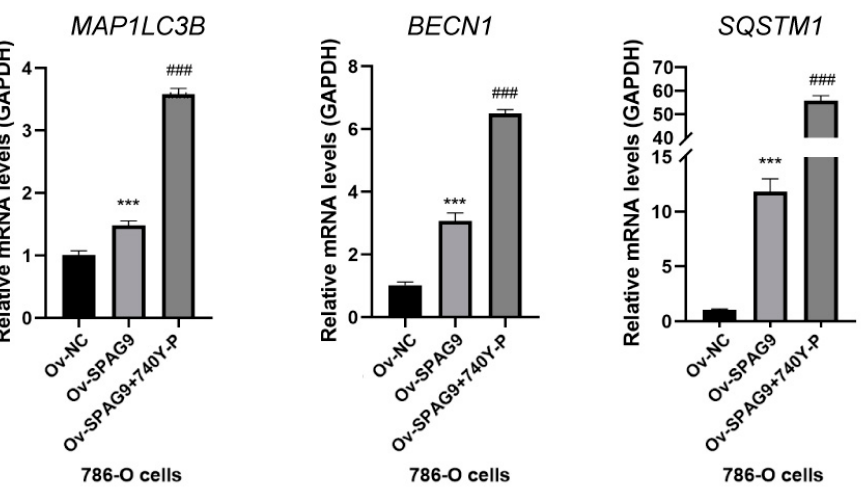
Figure 7. Effects of 740Y-P stimulation on autophagy-related genes in 786-O cells. *** p value < 0.001 vs. Ov-NC; ### p value < 0.001 vs. Ov- SPAG9 . Ov-NC: cells transfected with control plasmids; Ov- SPAG9 : cells transfected with SPAG9 plasmids; Ov- SPAG9 + 740Y-P: cells transfected with SPAG9 plasmids and stimulated by